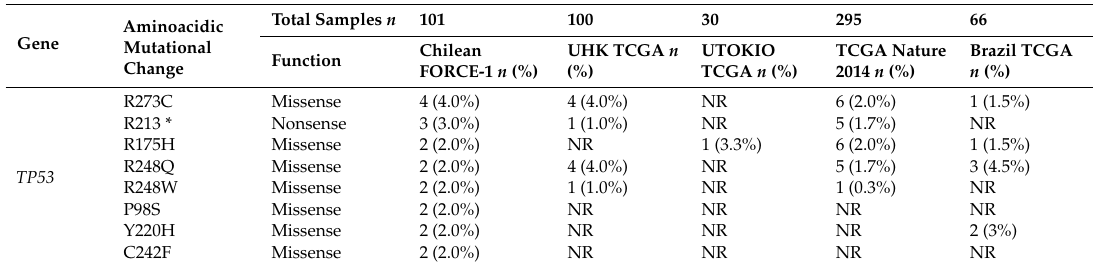
Table 4. Most frequent mutations ( > 2.0% prevalence) found in FORCE-1 samples and comparison with di ff erent TCGA